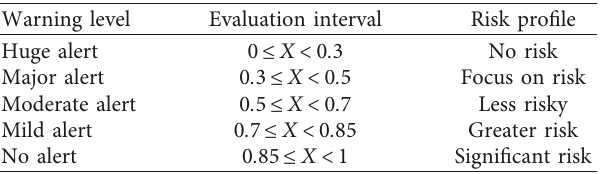
Table 7: Early-warning level evaluation interval risk situation description.